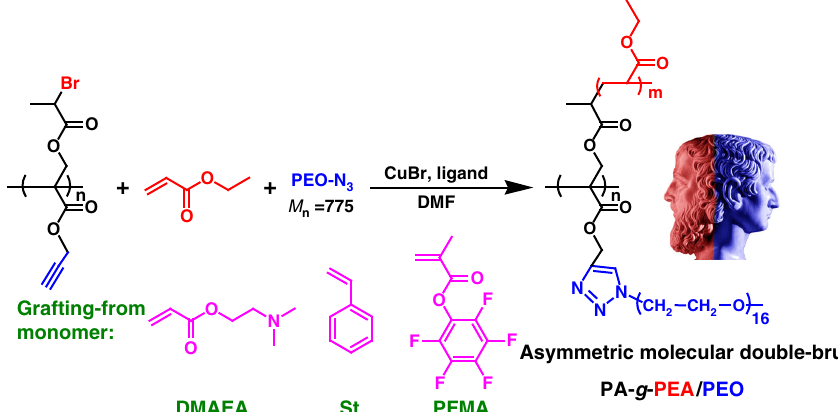
Fig. 1 Construction of asymmetric molecular double-brushes. Synthetic route of PA- g -PEA/PEO, PA- g -PDMAEA/PEO, PA- g -PS/PEO and PA- g -PPFMA/ PEO asymmetric molecular double-brushes in one-shot system via the combination of ATRP and CuAAC click reaction